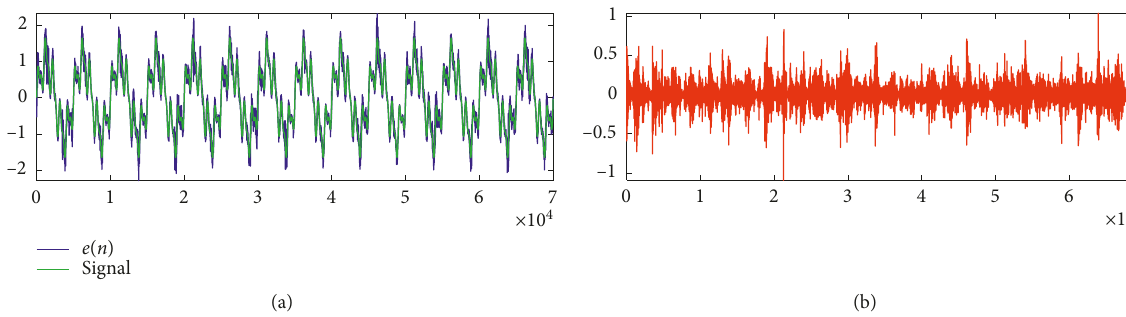
Figure 5: The residual noise of the NLMS algorithm. (a) Signal and e